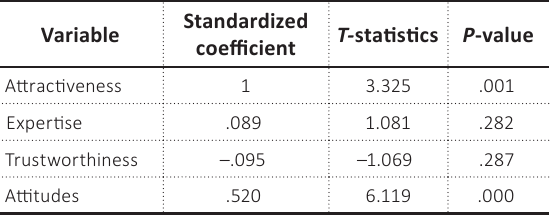
Table 6. Results of regression analysis